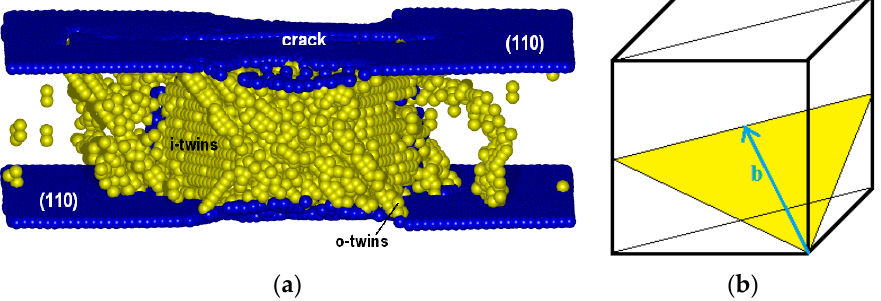
Figure 5. Temperature 300 K, biaxiality ratio α = 0.9: ( a ) generation of the inclined i-twins and oblique o-twins in 3D, time step 9700, K A ( t ) = 0.998 MPa m 1/2 ; ( b ) schematic orientation of {112} oblique twinning plane (yellow) with Burgers vector b (blue).